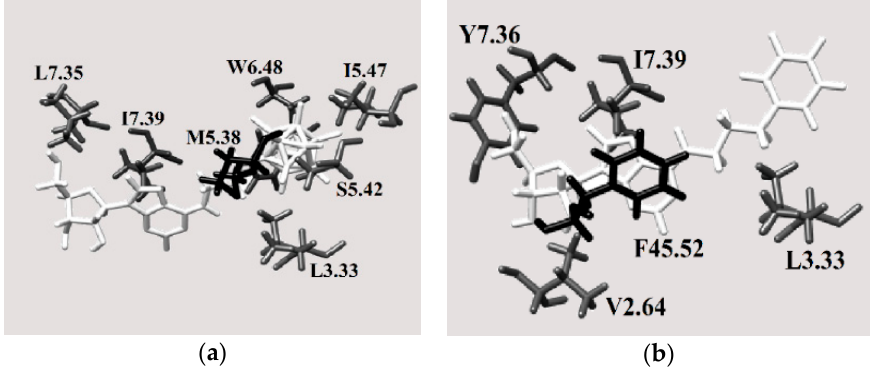
Figure 9. Views of the A3 receptor binding pocket for the best docked poses of ( a ) compound 3 and ( b ) compound 4 (white: ligand, gray: transmembrane residues, black: extracellular amino acids).